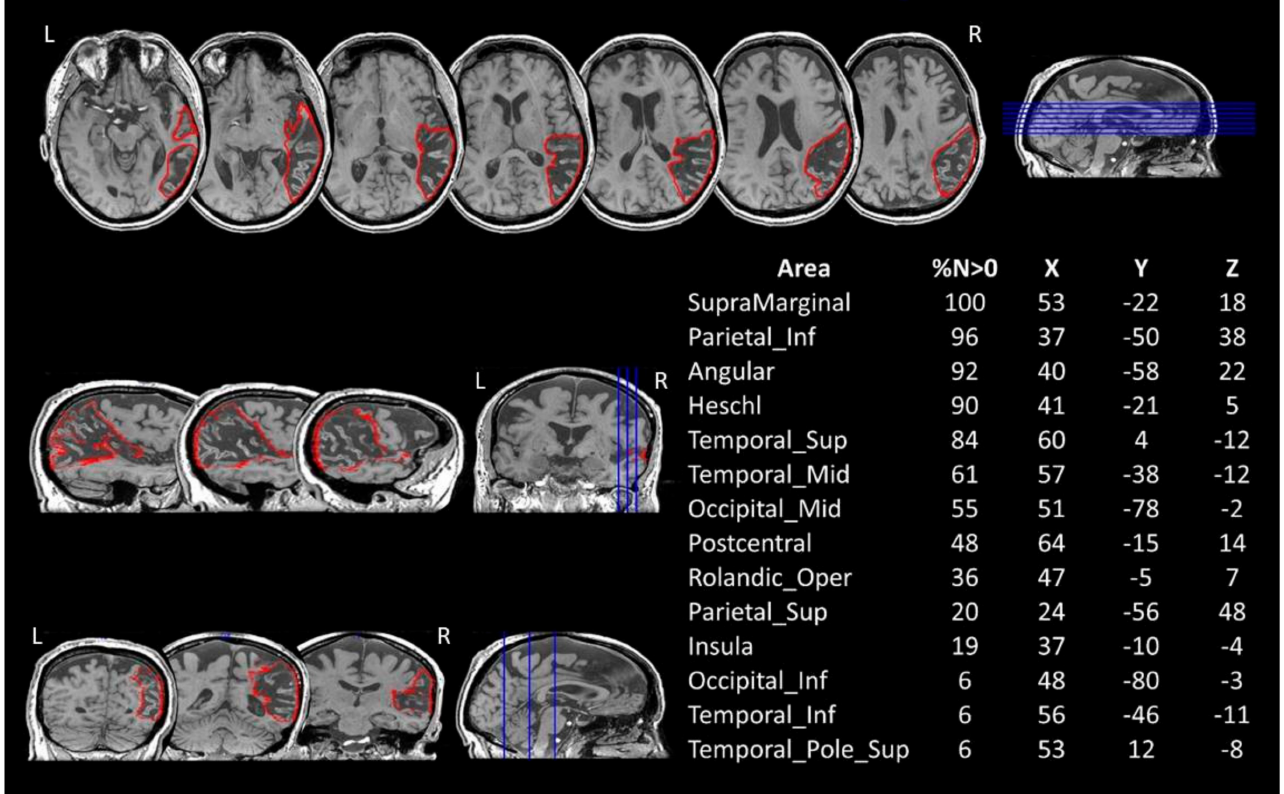
Figure 1. BG’s 3D-T1 MRI image and lesion mapping. Axial ( up ), sagittal ( middle-left ) and coronal ( bottom-left ) views are shown with the drawing of the lesion in the right hemisphere in red. The table on the right reports the percentage volume (% N > 0) affected by the lesion and the MNI coordinates (X, Y, Z) for each grey matter structure, as reported on MRIcron (AAL atlas). Lesion’s centre of mass = 140.42 × 84.64 × 97.34. L = left. R =